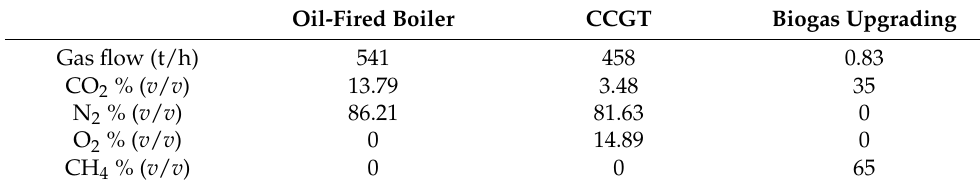
Table 2. Dry gas flow rates and compositions of three applications.